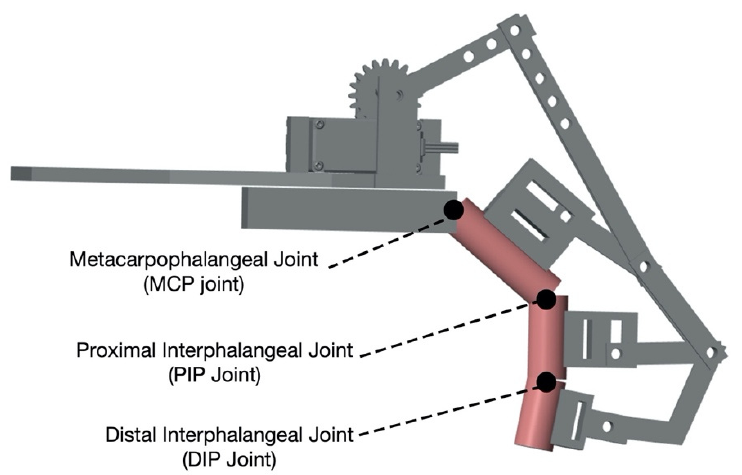
Figure 7. An image captured during the simulation test. The proximal, medial and distal phalanges were modeled as cylinders connected together by MCP, PIP and DIP joints, respectively.